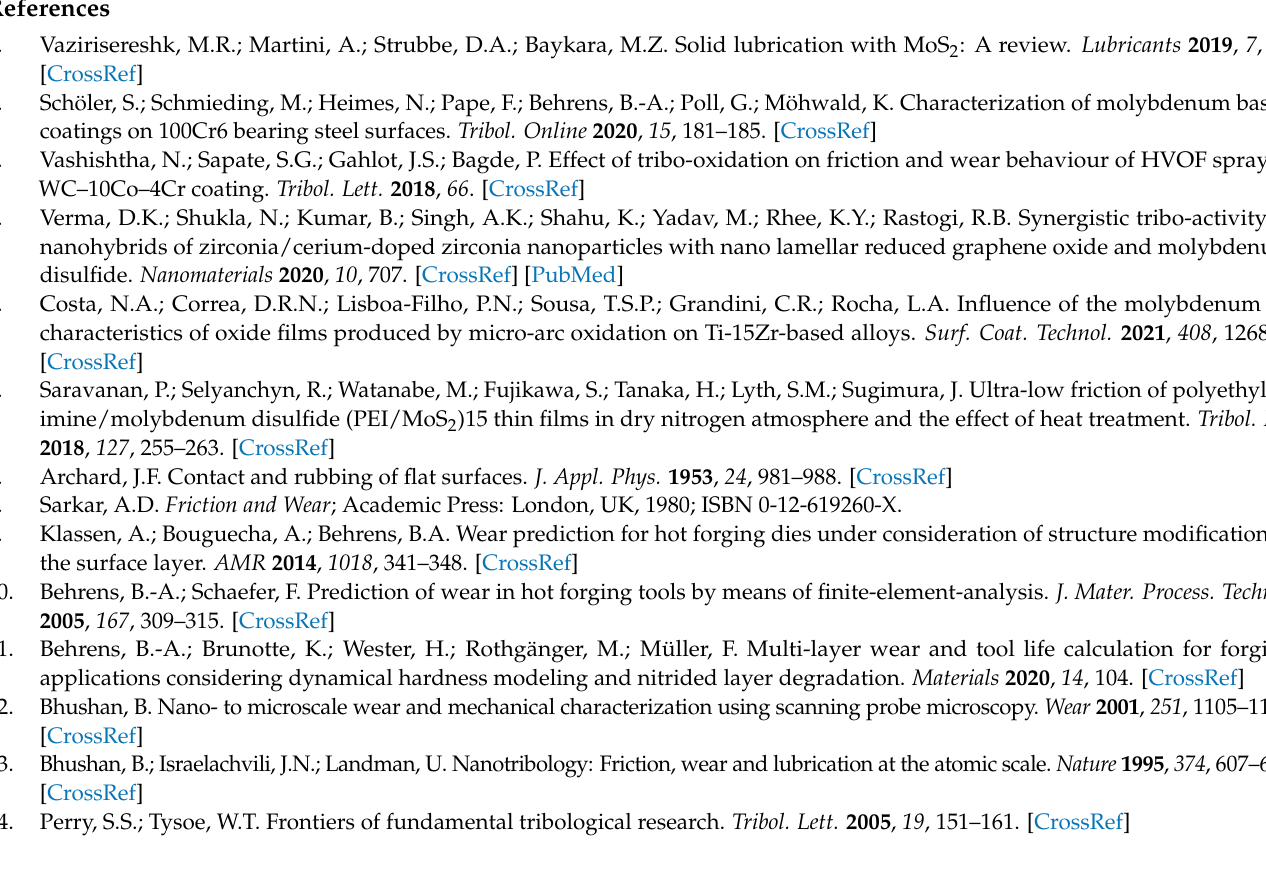
Figure A6. Development of the average wear volumes and average coefficients of wear over the number of passes of the MoO 3 ‐ coating: ( a ) 50 μ N; ( b ) 100 μ N; ( c ) 150 μ N; ( d ) 200 μ N.